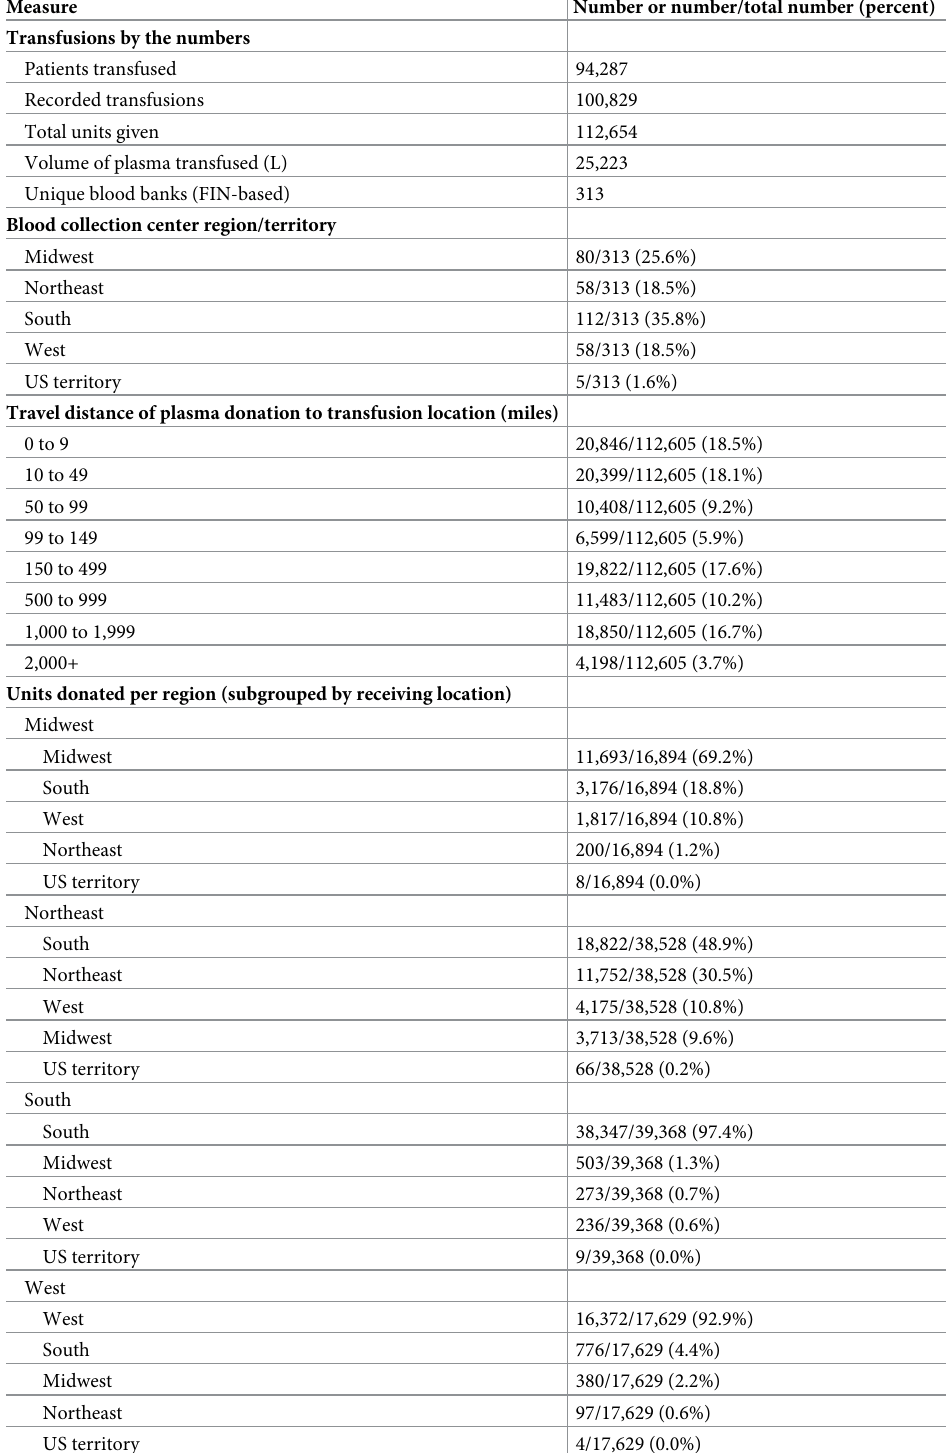
Table 4. Summary of blood collection facilities, donations, and plasma distribution supporting the US Expanded Access Program (EAP) for convalescent plasma AU : PleasecheckthattheeditstothecolumnheadsinTable 4 captureyourmeaning : Ifnot ; pleaseeditasnecessary :